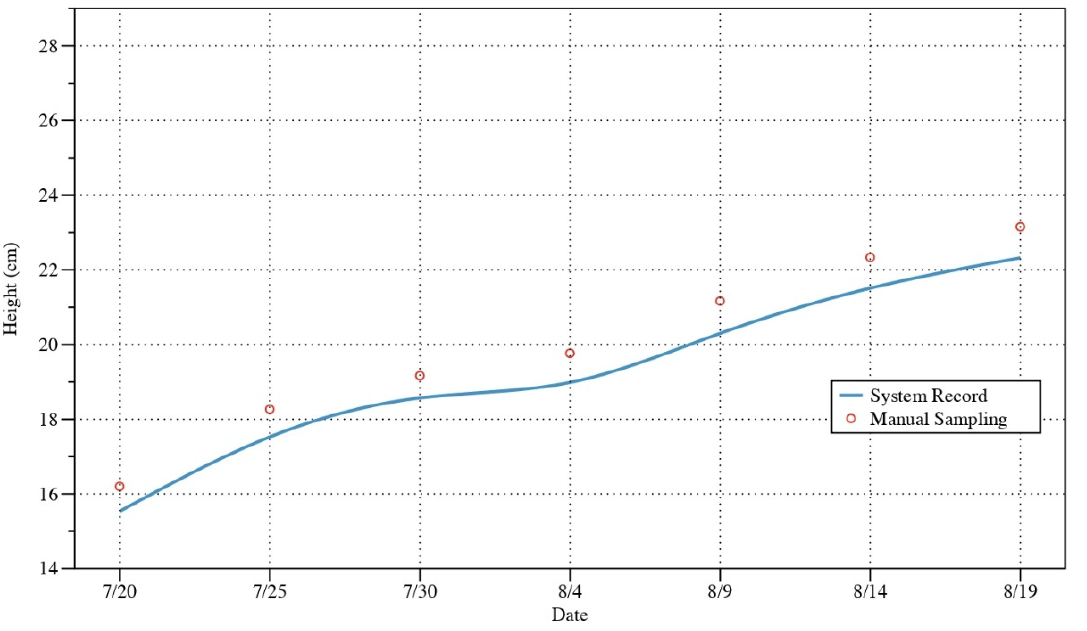
Figure 16. System record value and manual sampling of plant height. Table 6. Comparison of the results of plant height value.